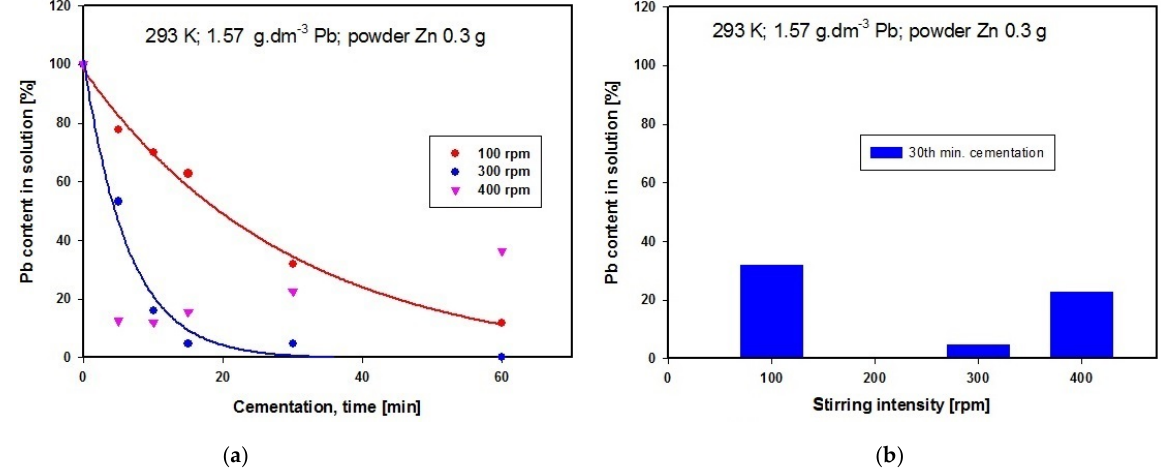
Figure 4. ( a ) Time dependence of Pb concentration in solution after cementation using zinc at different stirring rates at constant temperature; ( b ) Comparison of Pb concentrations in solution after cementation using zinc at different stirring rates at constant temperature.